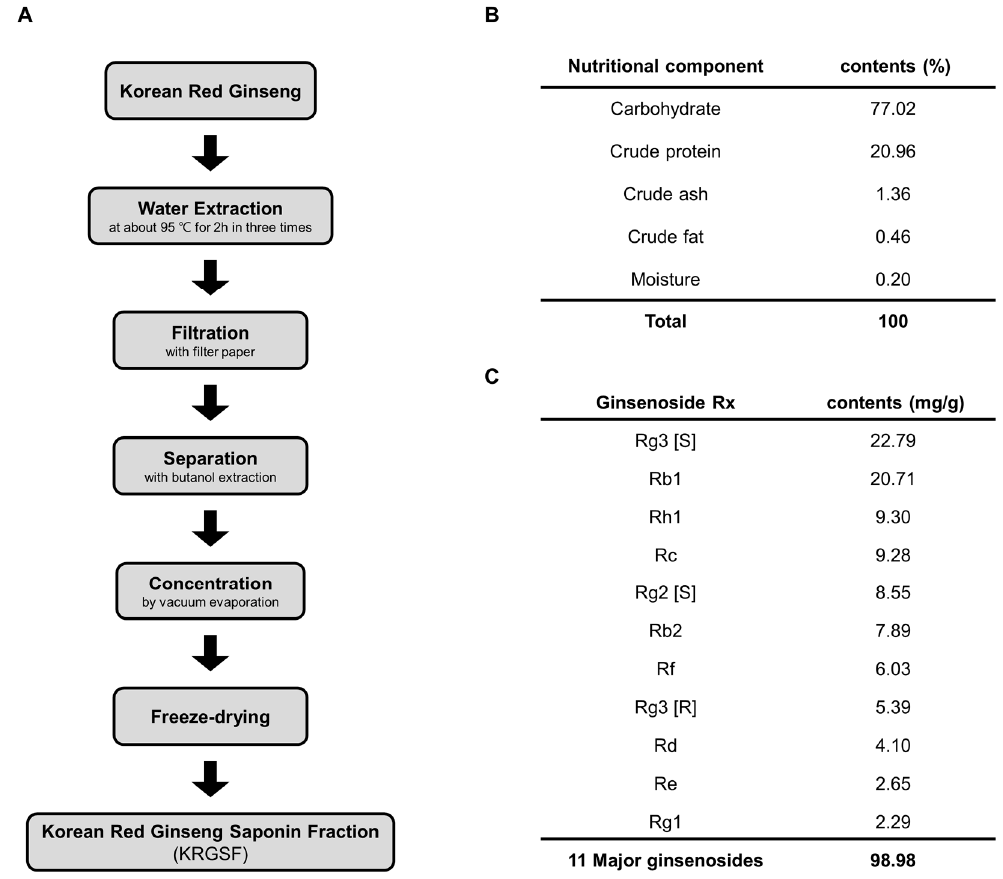
Figure 1. The nutritional composition and ginsenoside content of the Korean red ginseng saponin fraction. ( A ) Scheme for the preparation of the KRGSF. ( B ) The nutrient composition of Korean red ginseng saponin fraction (KRGSF). ( C ) The ginsenoside content of the KRGSF.